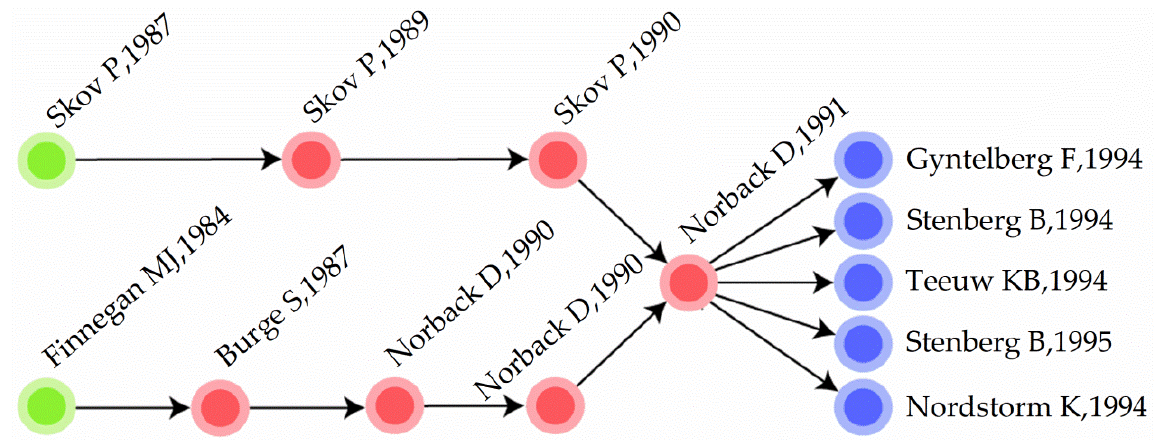
Figure 8. Phase path analysis of the SBS from 1984 to 1996. [21 – 29,34,42 –